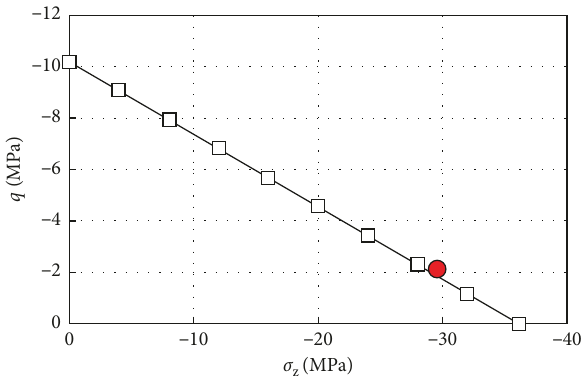
Figure 8: Envelope line of the plastic limit load and stress state evaluation of the shaft lining